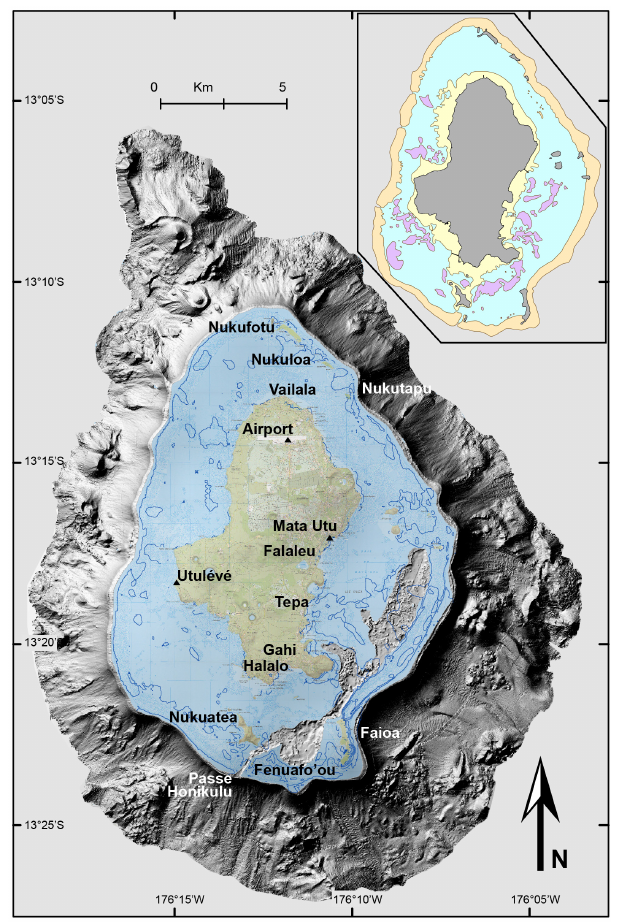
Figure 3. Wallis archipelago. Land and lagoon coloured map from IGN (2007b); the shaded seafloor topography of the seaward reef wall is from the WALFUT survey (Pelletier et al., 2011). Insert shows land in grey and reef types as barrier reef (orange), fring- ing reef (yellow) and patch reef (pink) from the Reef Base database (http://www.reefbase.org).